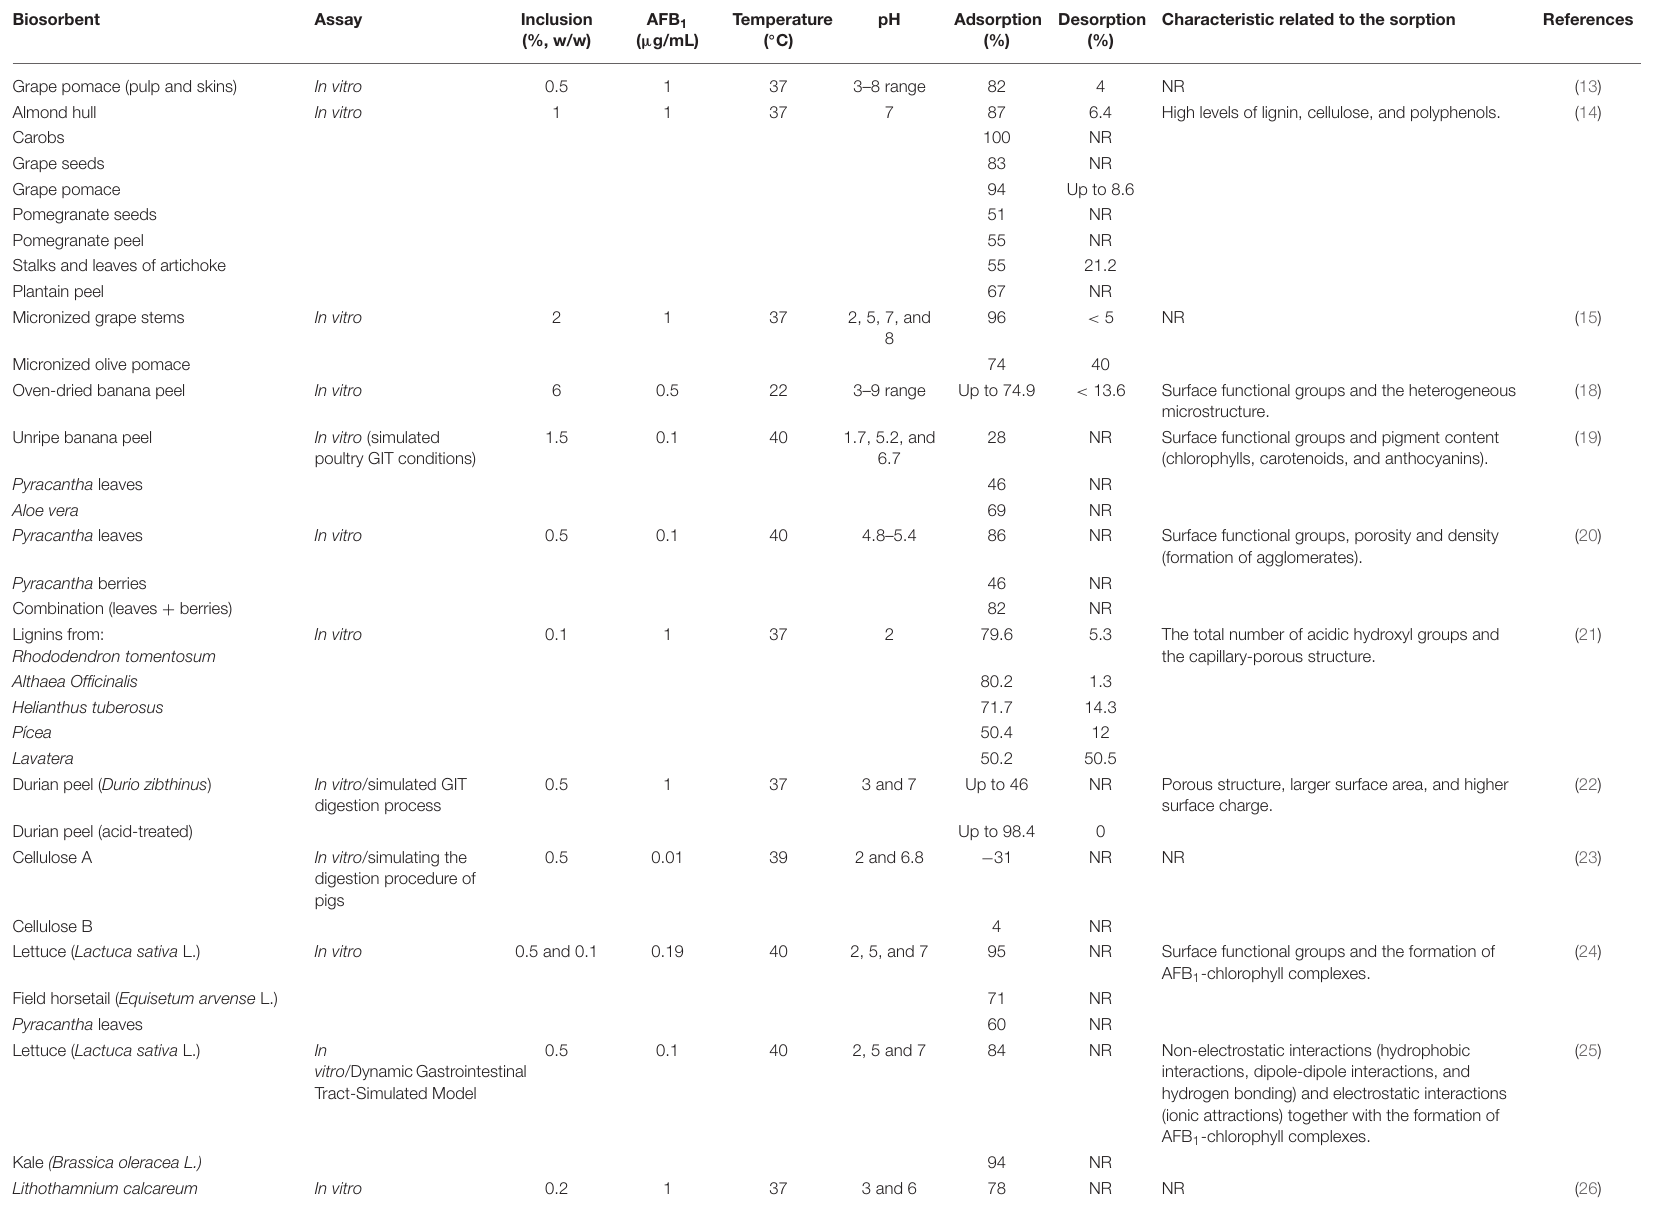
TABLE 1 | In vitro effectiveness of different agro-waste-based materials to adsorb and desorb aflatoxins and the most important characteristic of the material related to the sorption.